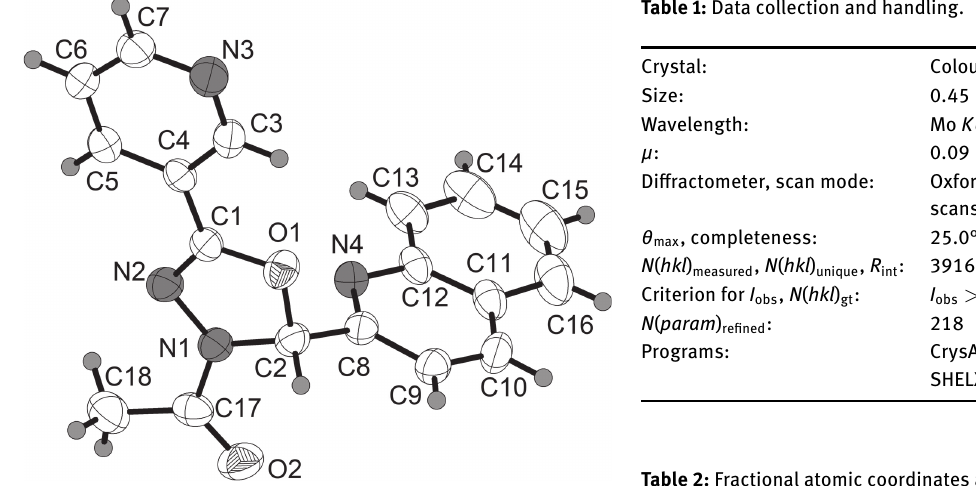
Table 1: Data collection and handling.